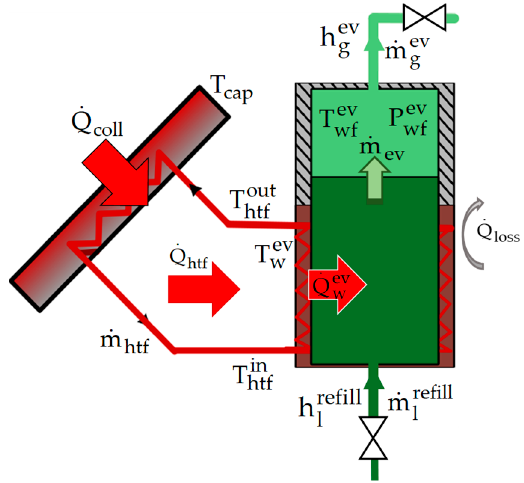
Figure 4. Schematic of evaporator modeling.